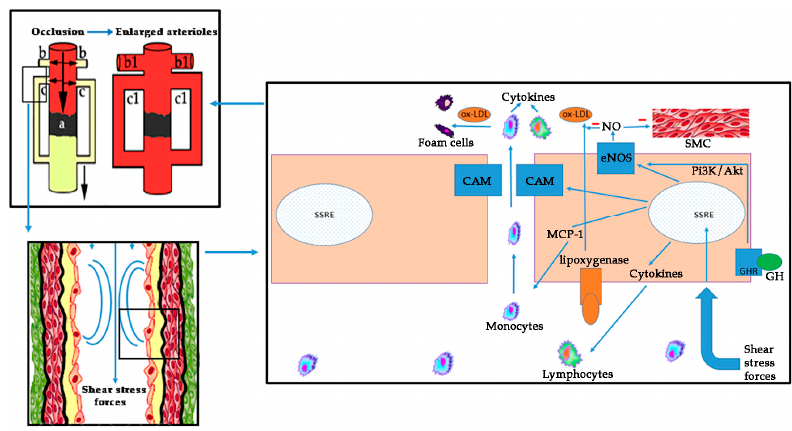
Figure 6. Mechanism of arteriogenesis. Oxidative stress at endothelial cell level produces LDL oxidation (ox-LDL) and foam cells formation that compose atheroma plaque, and, in the end, determine the vessels occlusion. After an arterial occlusion (a), the increase in shear stress forces through the collateral vessels (b, c) activates shear stress genes (SSRE) triggering the arteriogenic response. Adhesion molecules (CAM) and some cytokines such as MCP-1 are produced by the endothelial cells, attracting monocytes and lymphocytes from the blood to the vascular wall that start